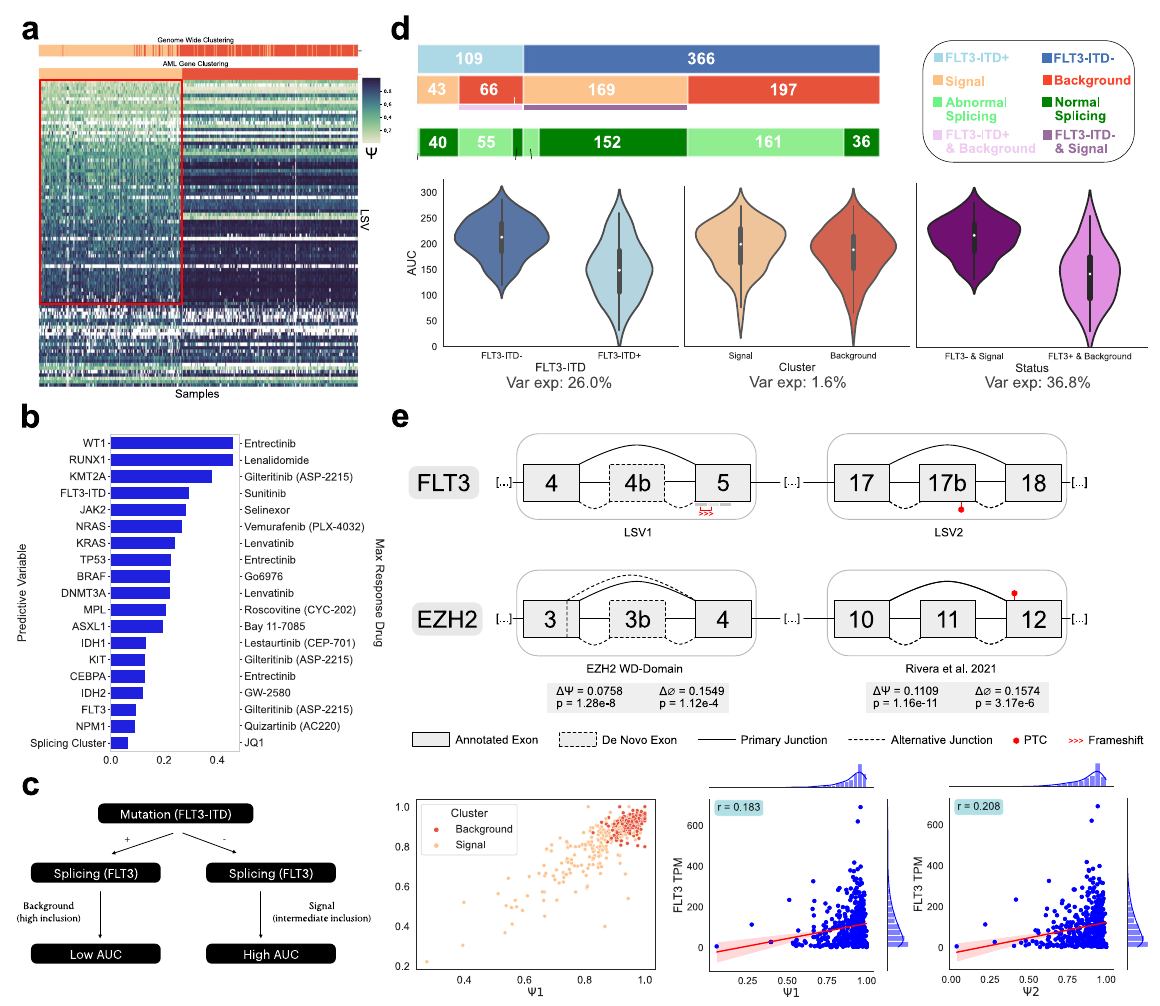
Fig. 5 | AML Drug Response Analysis. a Heatmap showing the tile discovered by CHESSBOARD in LSVs from 70 AML related genes (samples=477, LSVs=90). The signal (samples=214, LSVs=66) is outlined in red. The top “ Genome Wide Clus- tering ” track shows sample grouping in Fig. 3a. b Barplot showing for each cate- gorical variable (mutation presence or splicing cluster assignment, left) the drug (right) with the maximum AUC variance explained (x-axis) by the corresponding variable. c The proposed decision tree for administering Sorafenib based on spli- cing patterns and mutations. Patients with FLT3 -ITD- and a signal group splicing patternexhibit a worse response (high AUC) compared to patients with FLT3 -ITD+ andabackgroundgroupsplicingpattern(lowAUC). d ViolinplotsofAUCvaluesfor patients'responsetoSorafenibwhensplitaccordingtothegroupsindicatedonthe x -axis.Whencombiningbothsplicingandmutationinformationusingthedecision tree in ( c ), the variance explained increases to 36.8%. The bars at the top indicate the total number of samples that fall into each category. Notably, the groups